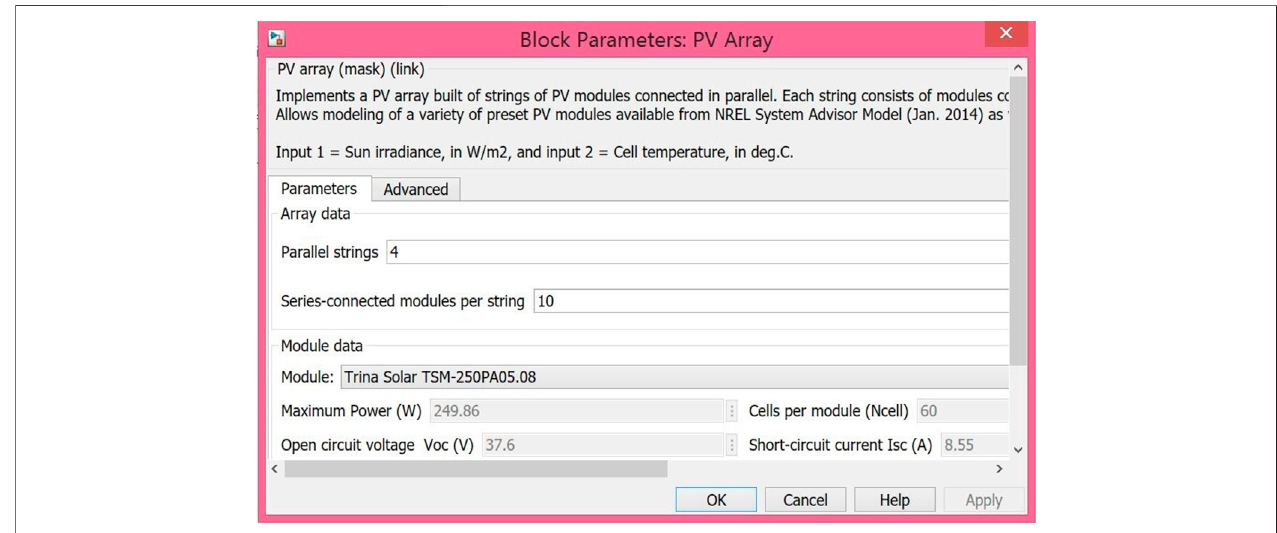
FIGURE 6 | Parameter Con fi guration of PV arrays.